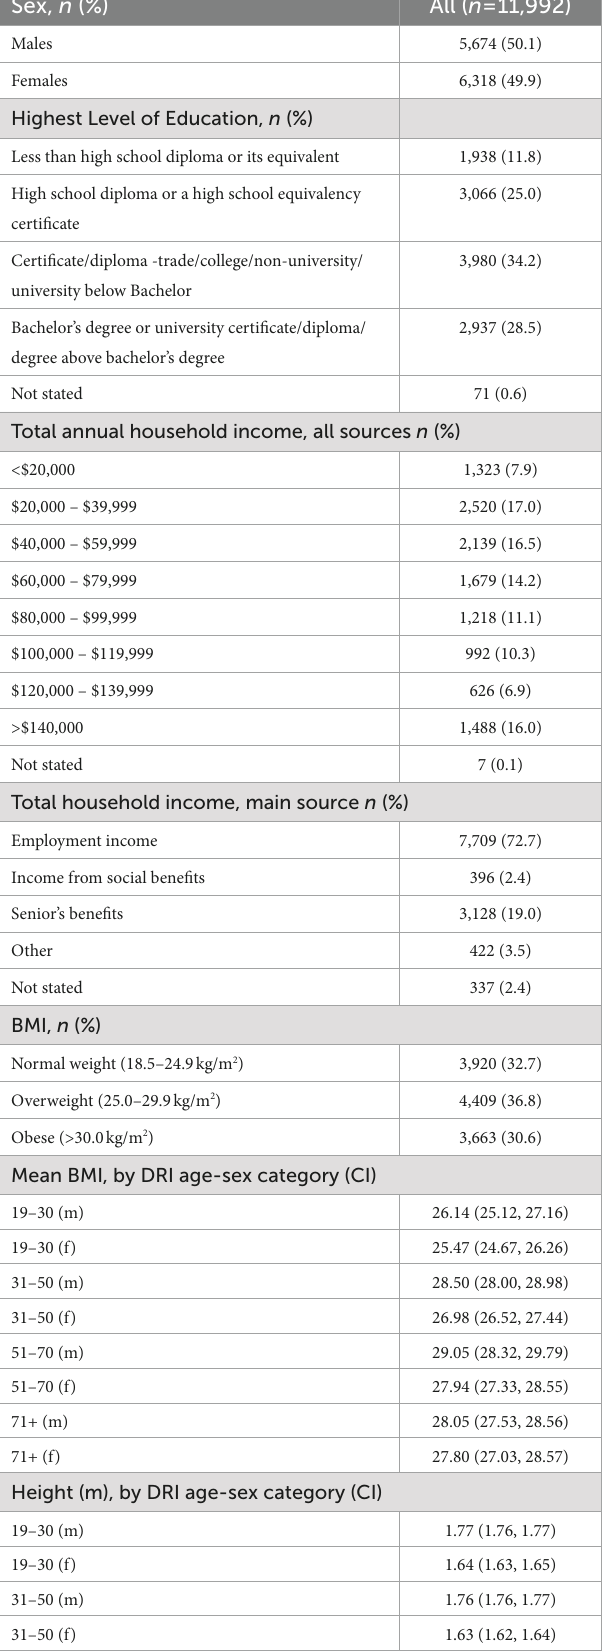
TABLE 2 Sample characteristics, adults ( ≥ 19